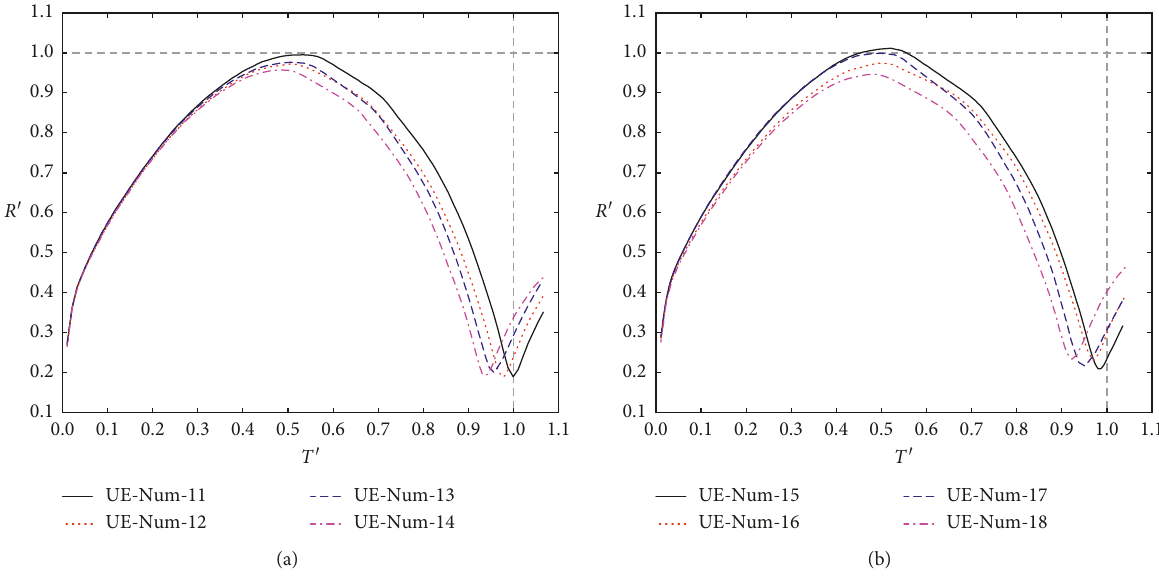
Figure 12: Curves of bubble radius with time at different boundary models: (a) 40 g and (b) 50 g .